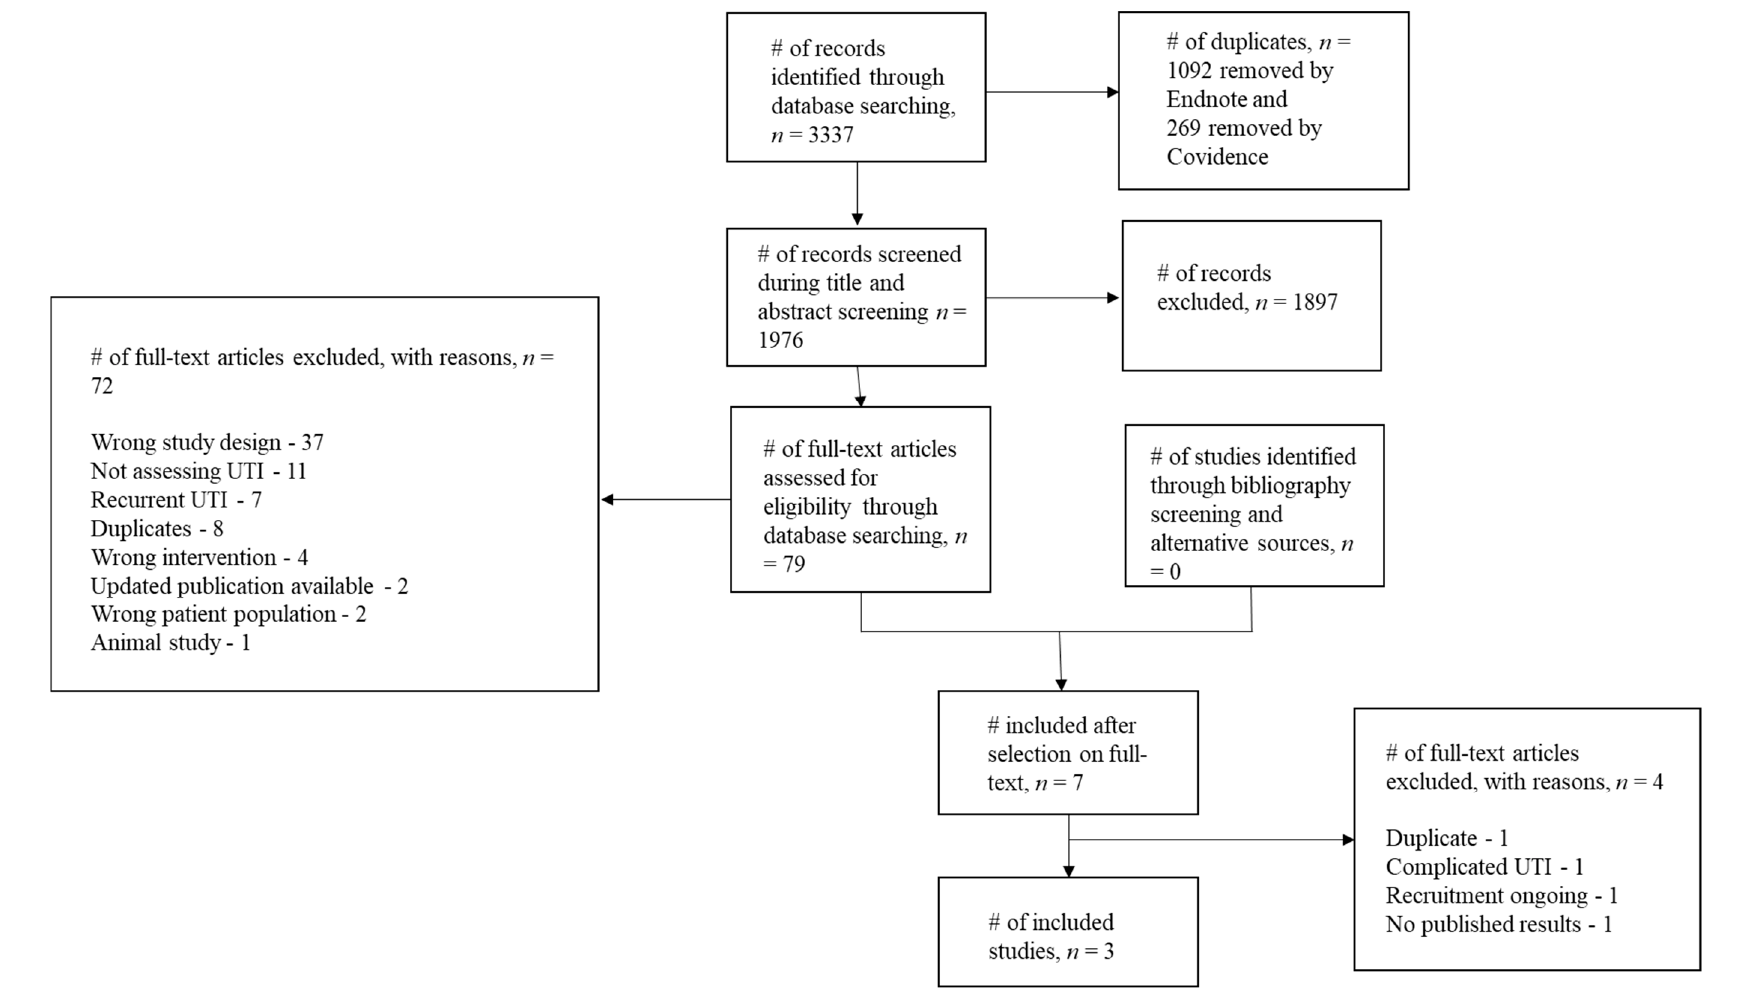
Figure 1. Flow chart showing the process for identification of studies eligible for inclusion.